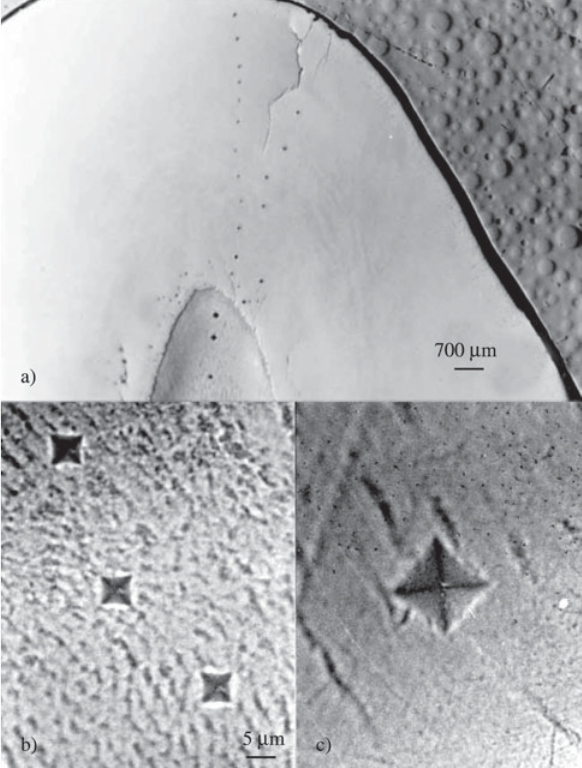
Figure 4 . Light microscope images of well-shaped indentations in enamel. They present good shapes to obtain the VHN values of human tooth because both diagonals have the same length and they are straightly reading. a) Sequence of indentations through enamel, EDJ, and dentin corresponding to the cusp zone (zone 3); b) In- dentations in enamel; c) indentation in